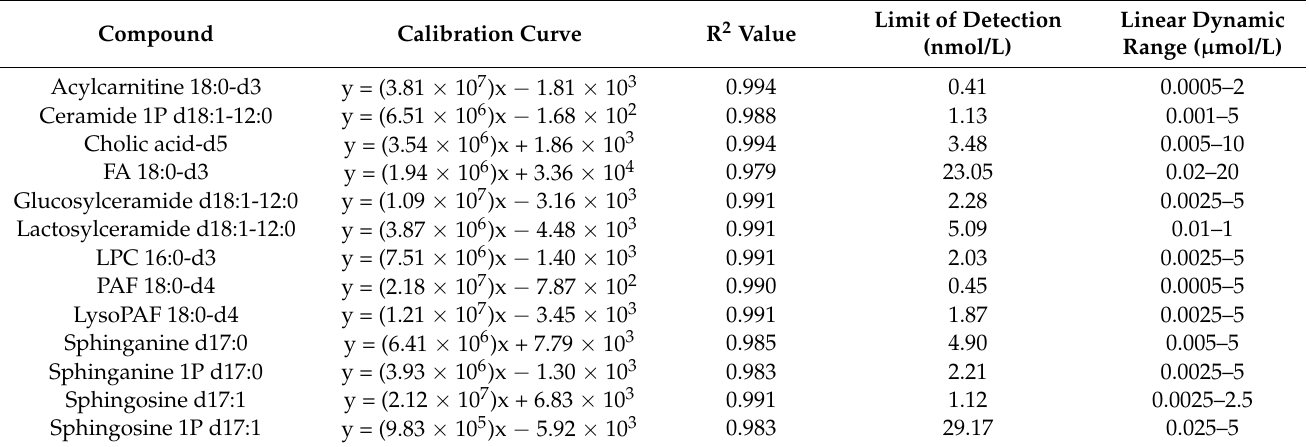
Table 1. Linearity, sensitivity, and dynamic range of internal standard (IS) in the liquid